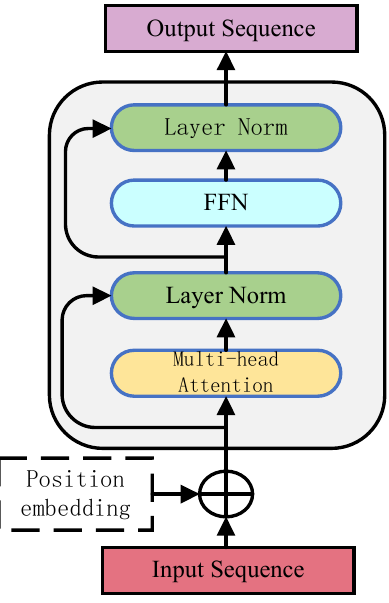
Figure 5. The original encoder structure in paper